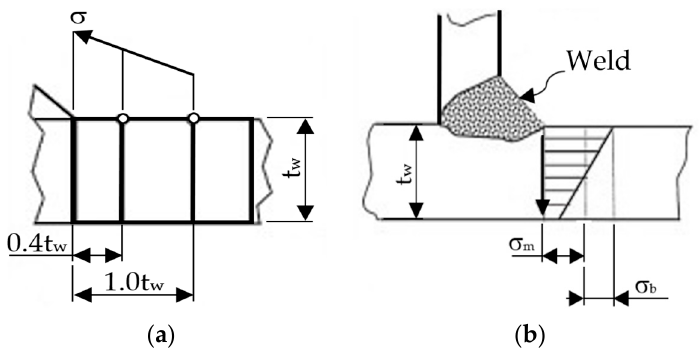
Figure 1. ( a ) Linear hot-spot stress extrapolation [39]; ( b ) membrane components ( σ m ) and bending ( σ b ) of the structural stress ( σ s ) at the weld toe [34], (adapted by the author [40]).